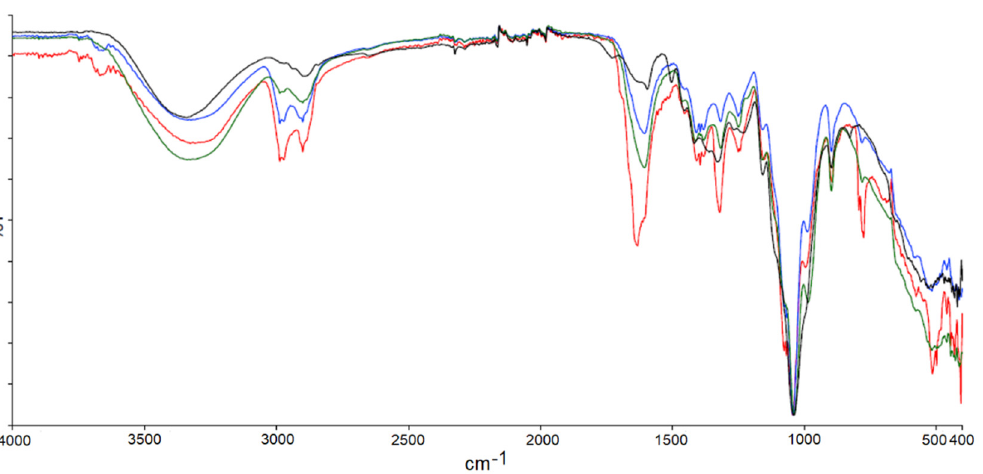
Figure A3. FTIR-ATR overlap of cellulose fractions of all biomasses: Licorice Root (L, red), cellulose Palm Leaf (P, blue), cellulose Willow (W, green) and cellulose Holm Oak (OH, black). Also, for hemicellulose fraction, similar peaks can be designed. The IR spectrum in Figure A4 show strong –OH stretching and –CH, –CH 2 , –CH 3 absorption at 3320 and 2950 cm − 1 , respectively. The characteristic and very high in intensity peak at 1630 cm − 1 is due to